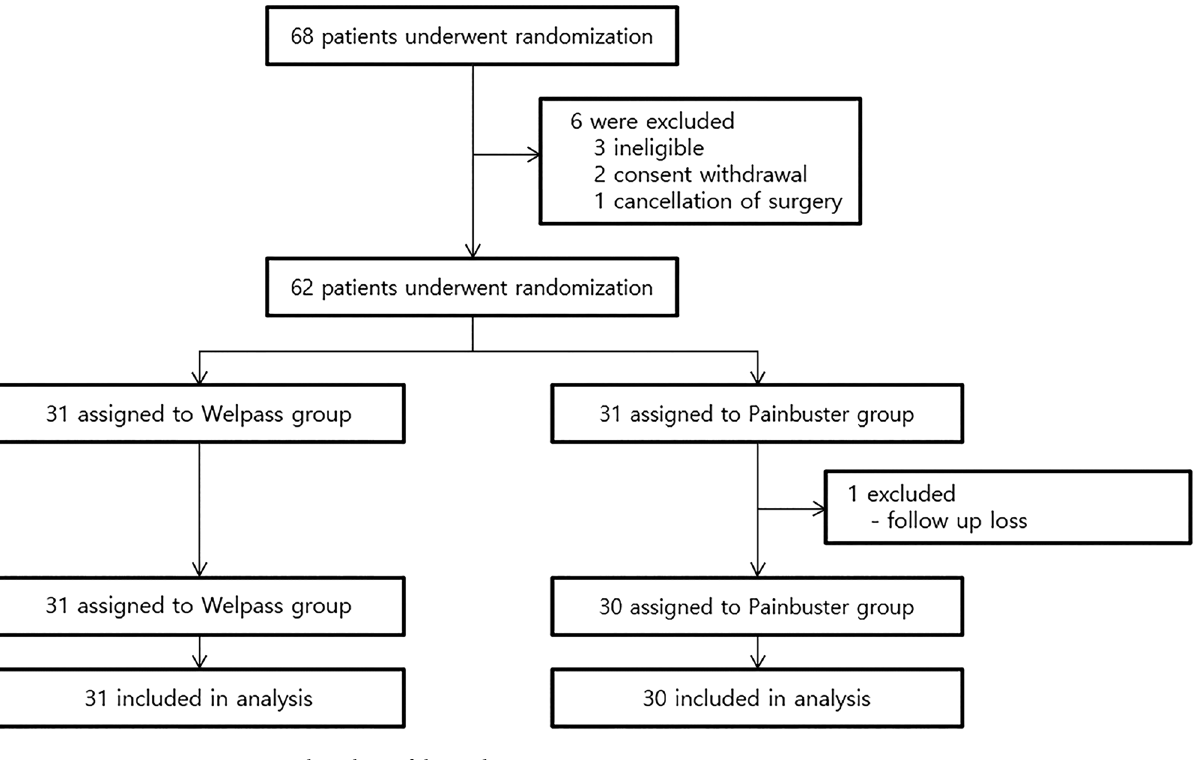
Figure 1. Flow chart of the